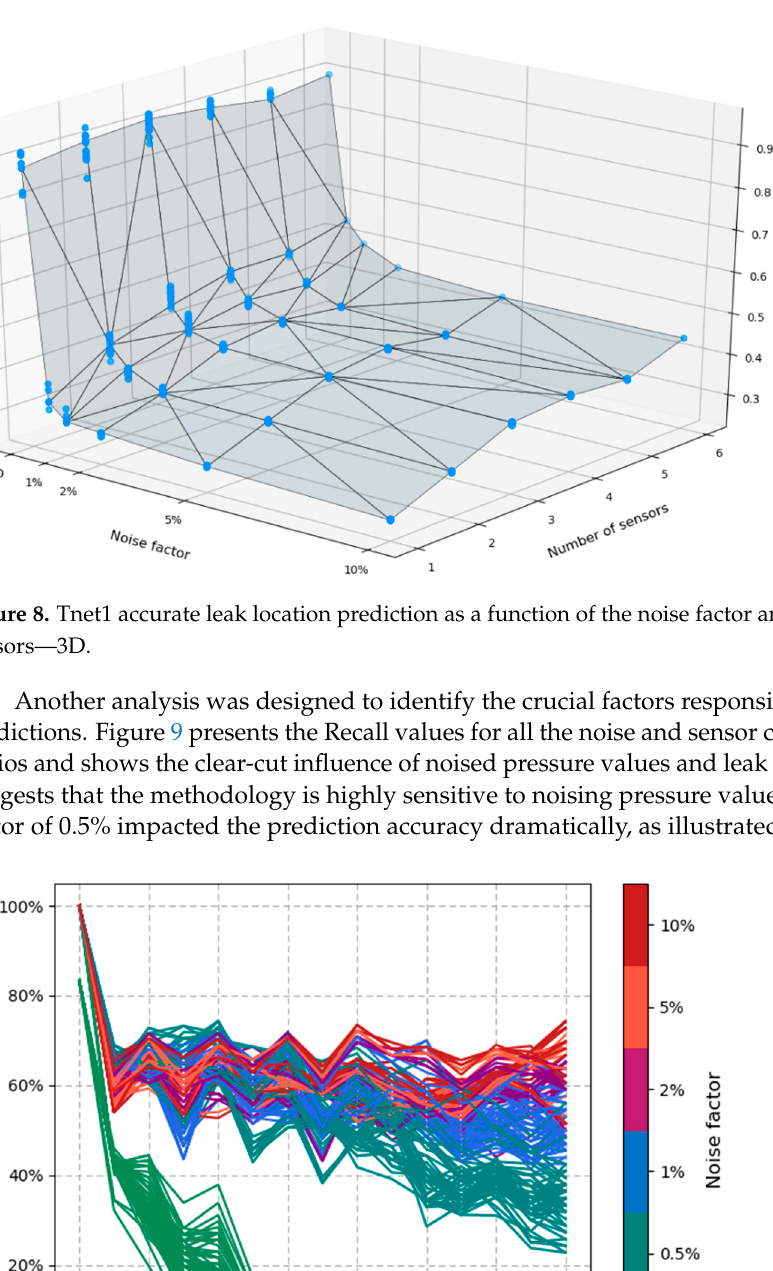
Figure 9. The impact of the noise factor on the prediction accuracy.